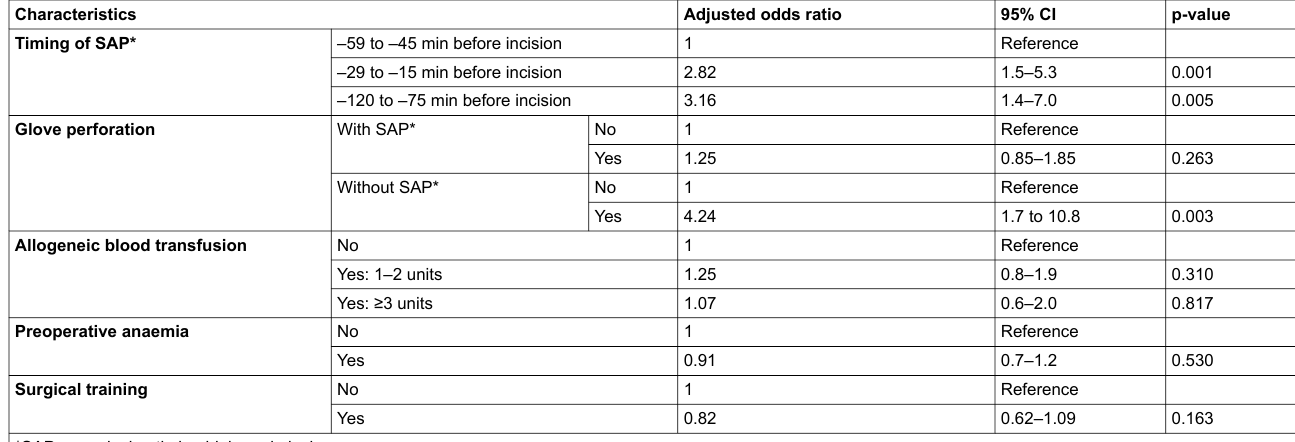
Table 1: Adjusted odds ratio of contracting surgical site infection by occurrence of potential risk factors in multivariable analyses.